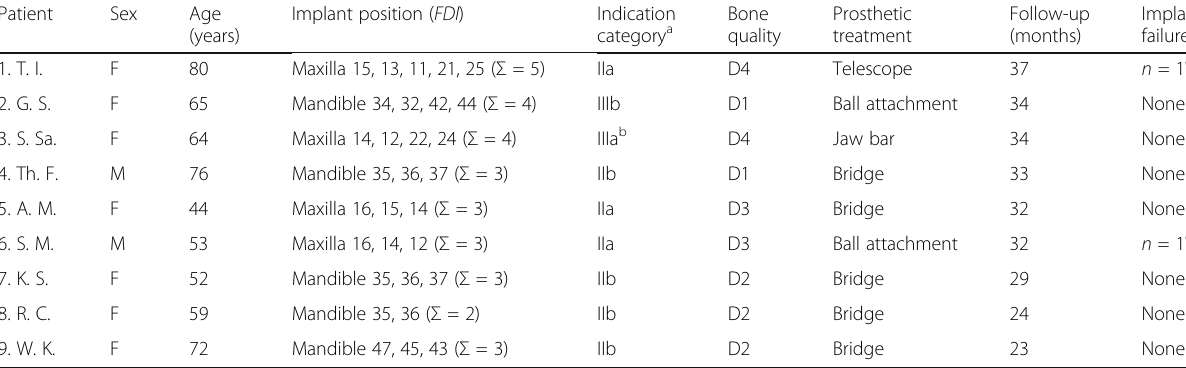
Table 4 Clinical characteristics of the study cohort Patient